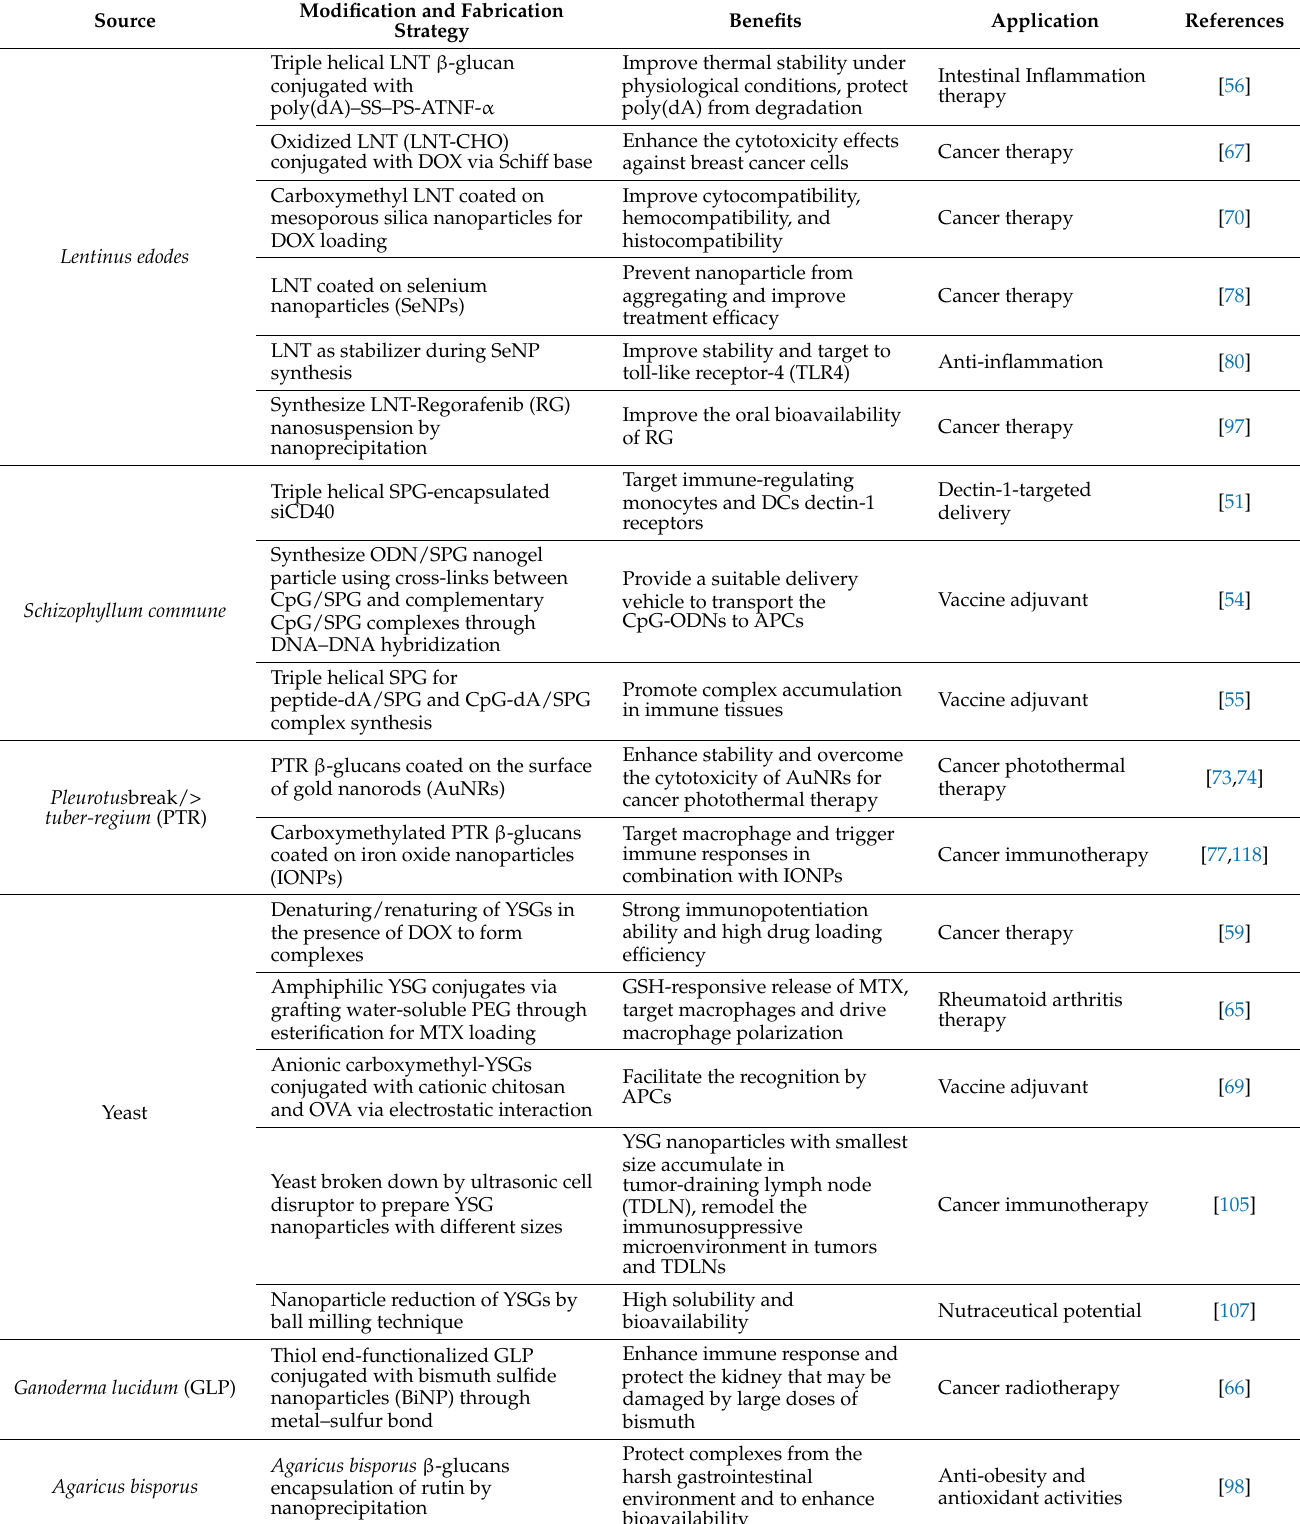
Table 1. Examples of β -glucan from different fungi resources used as